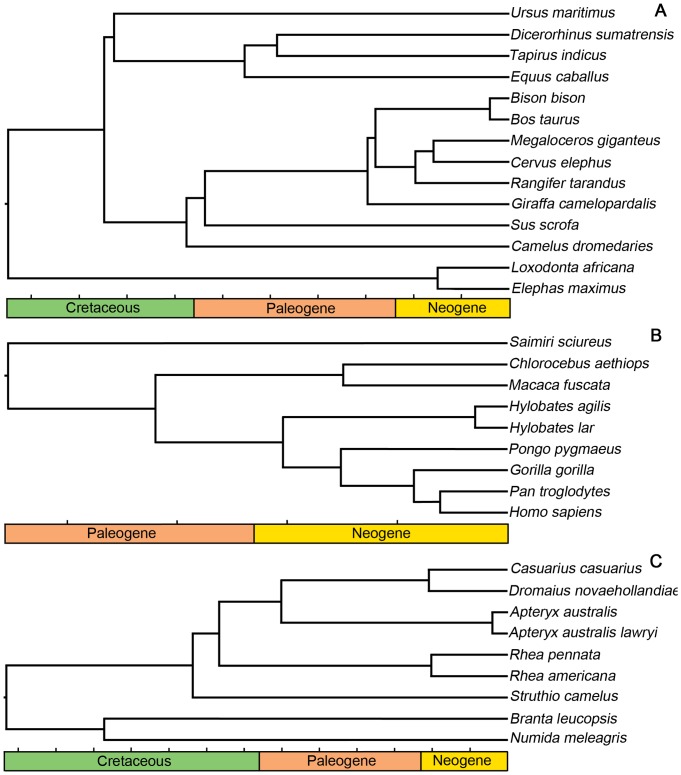
Consensus trees used in phylogenetic analysis.Tick marks represent increments of 10 million years. A, non-primate mammal tree topology and branch lengths derived from [37]–[44]; B, primate tree derived from [45]; C, bird tree derived from [46]–[48].